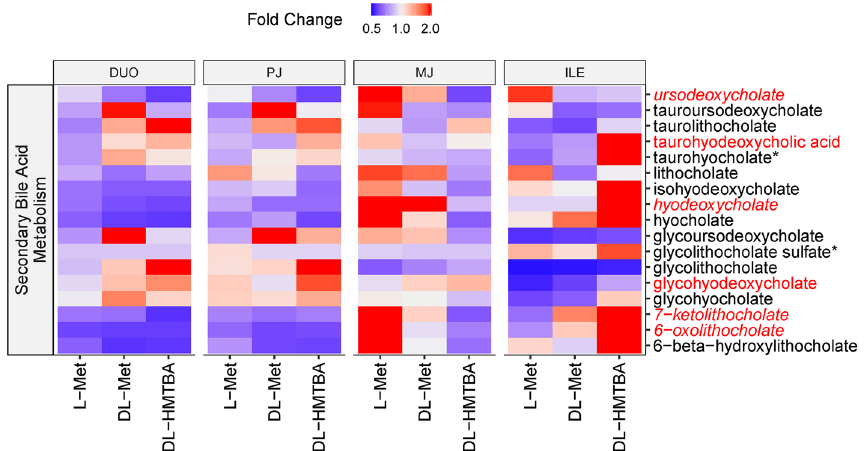
Figure 4. Heat map of the secondary bile acid metabolism pathway, showing the distribution of all measured pathway-related metabolites along duodenum (DUO), proximal jejunum (PJ), middle jejunum (MJ) and ileum (ILE) in pigs pre-fed with L-Met, DL-Met or DL-HMBTA. Blue color indicates lower abundance whereas red color indicates higher abundance of metabolites. Red writing of individual metabolites indicates a treatment effect or, if combined with italics, a region × treatment interaction ( P <